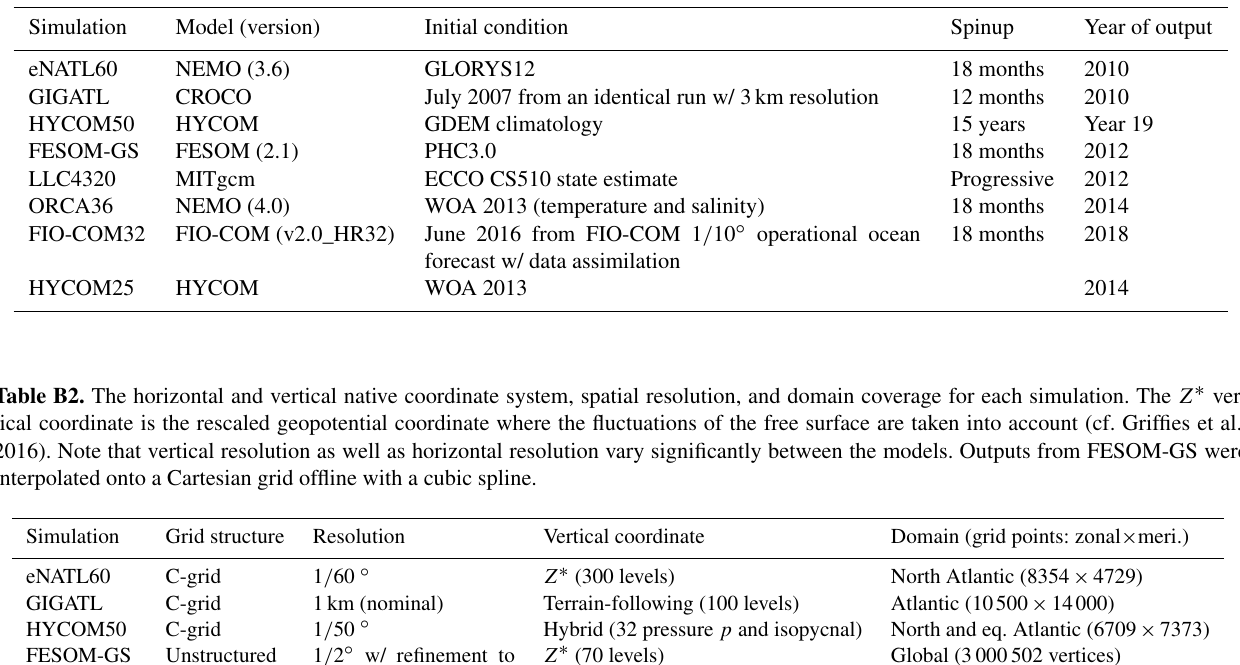
Table B1. The model and initial condition used for each simulation and their duration of spinup and year of output stored on OSN. HYCOM50 was spun up from the rest and integrated for a total of 20 years. Sensitivity experiments were performed starting from year 15 (Chassignet and Xu, 2017, 2021). LLC4320 used progressive spinup from a 1 / 6 ◦ state estimate (Menemenlis et al., 2008) followed by 1 / 12 and 1 / 24 ◦ simulations, as detailed in Table D2 of Rocha et al. (2016).